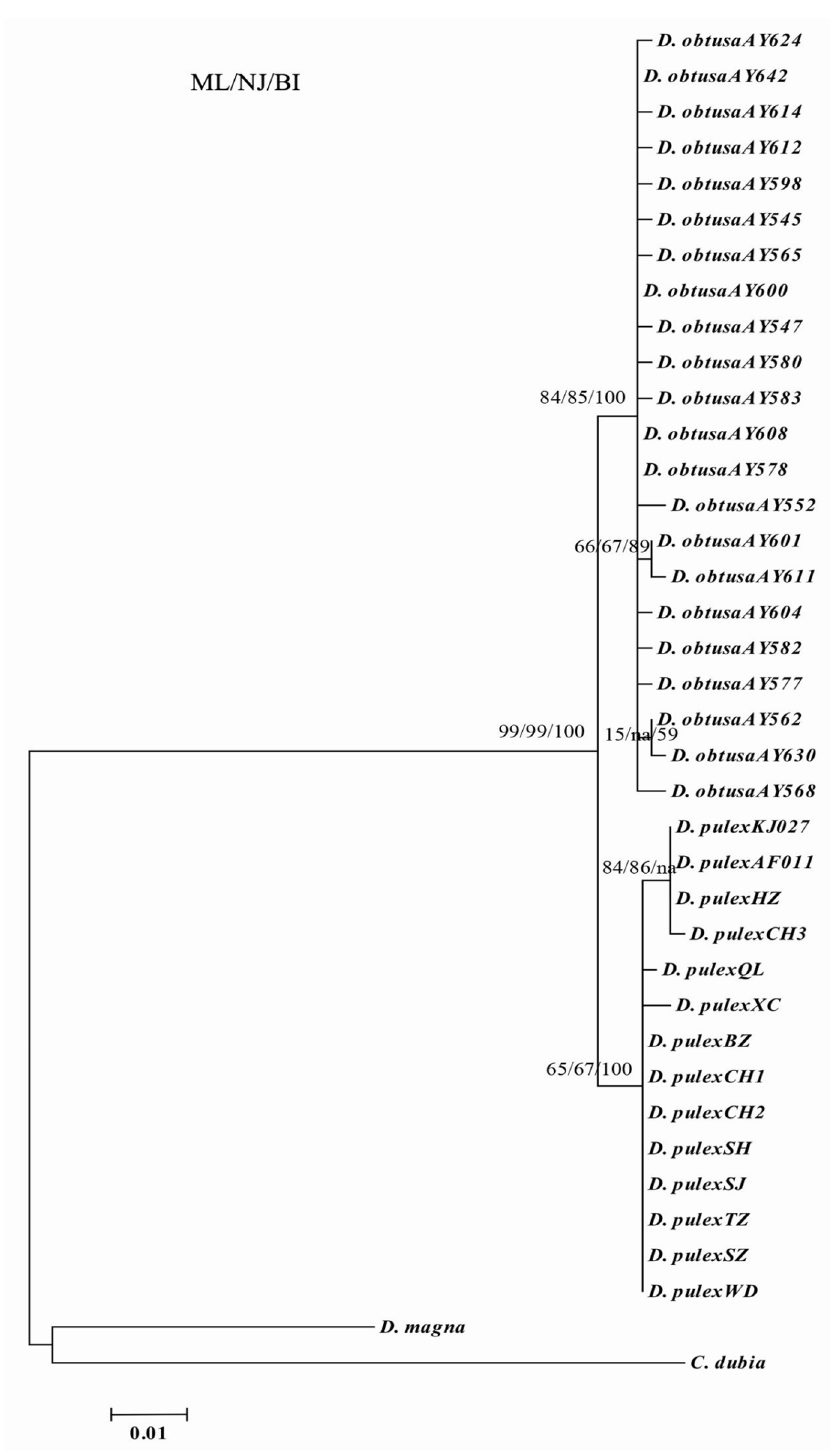
Fig 4. The phylogeny of D . pulex inferred from 18S gene sequences as a consensus tree formed from trees constructed using maximum likelihood (ML), and neighbor-joining (NJ), Bayesian inference (BI)